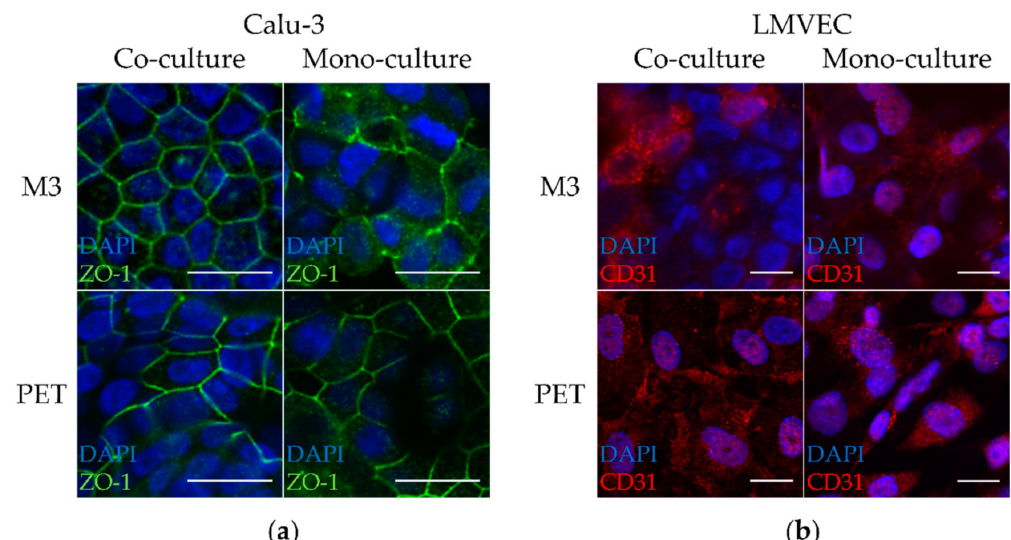
Figure 2. Staining of the tight junction protein Zonula Occludens 1 (ZO-1) and the endothelial marker CD31 of co- and mono-cultures of Calu-3 cells and human lung microvascular endothelial cells (LMVECs) in inserts on M3 membranes. Cells grown on inserts with PET membranes were used as controls. ( a ) Calu-3 cells were cultured and submerged for 8 days, followed by 2 weeks of culture at ALI. Cells are stained for the cell nucleus (blue) and tight junctions (ZO-1, green), magnification: 3200 × , scale bar: 20 µ m. ( b ) LMVECs after 3 weeks of submerged culture. Cells are stained for the cell nucleus (blue) and CD31 (red), magnification: 1600 × , scale bar: 20 µ m. Images are representative for observations of samples from two independent experiments (total N =